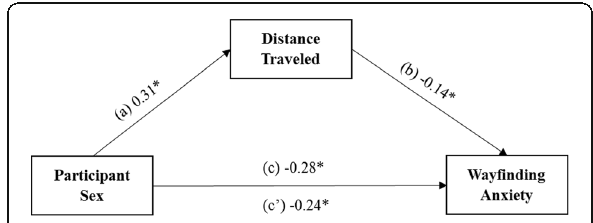
p = .069. Critically, distance traveled remained negatively related to route strategy, even when controlling for par- ticipant sex and trait anxiety, B = − 0.226, p = .005 (see Fig. 6 for scatterplot of relationship between distance traveled and route strategy, controlling for participant sex and trait anxiety). Again, the negative effect of dis- tance traveled on route strategy was present for females, B = − 0.296, p = .001 but not males, B = − 0.154, p = .307. Total childhood wayfinding experience negatively predicted wayfinding anxiety, B = − 0.190; p = .009, whether controlling for participant sex, B = − 0.150, p = .042 or trait anxiety, B = − 0.157, p = .023, but not when controlling for both simultaneously, B = − 0.124, p = .076. This negative effect controlling for trait anxiety was found for males, B = − 0.253, p = .027, but not females, B = − 0.046, p = .599. More specifically, distance traveled, B = − 0.200, p = .003, but not time